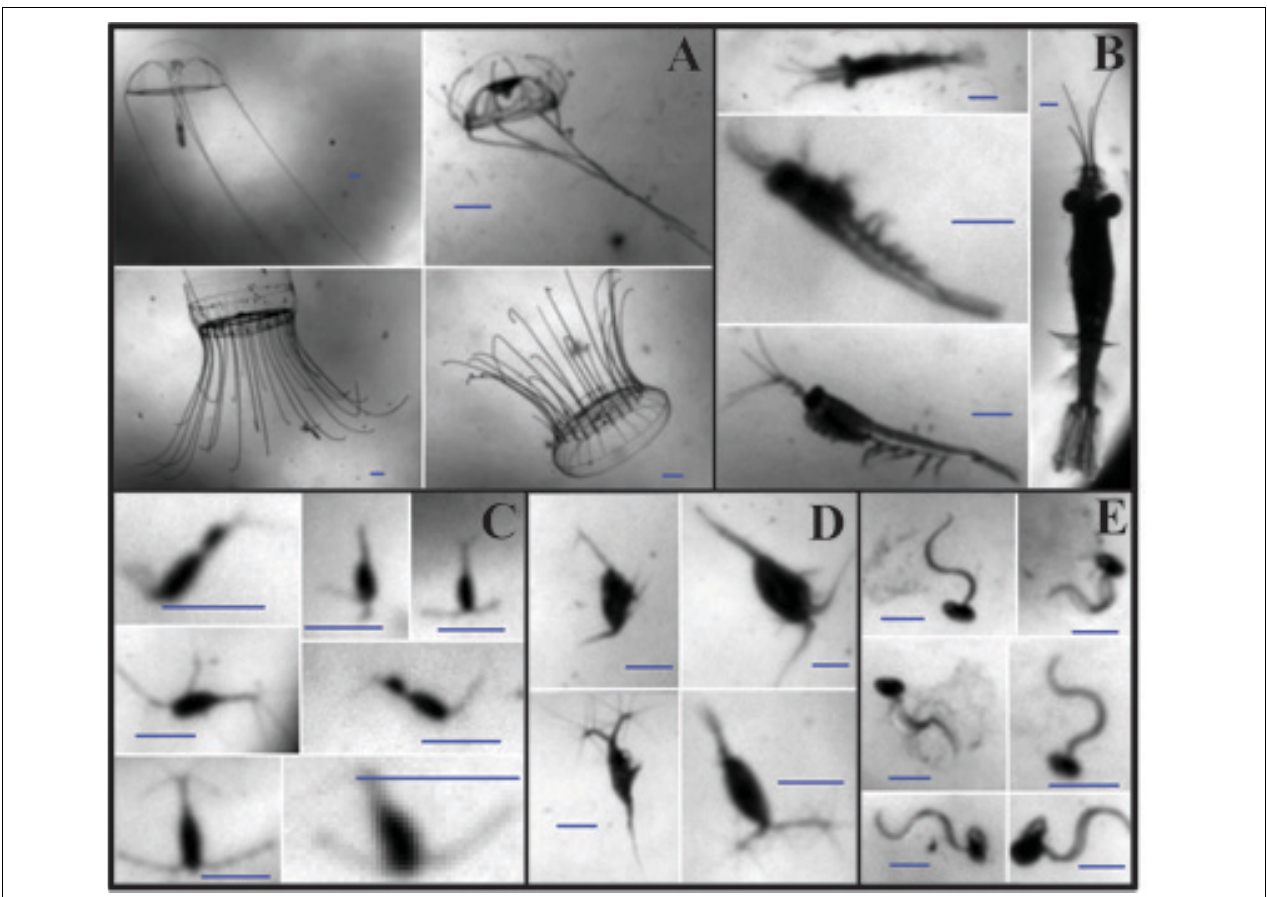
FIGURE 2 | Examples of zooplankton images from the O-Cam system. (A) Hydromedusae; (B) Euphausiids; (C) Cyclopoid copepods; (D) Calanoid copepods; (E) Appendicularians. All the scale bars are 1 mm long.